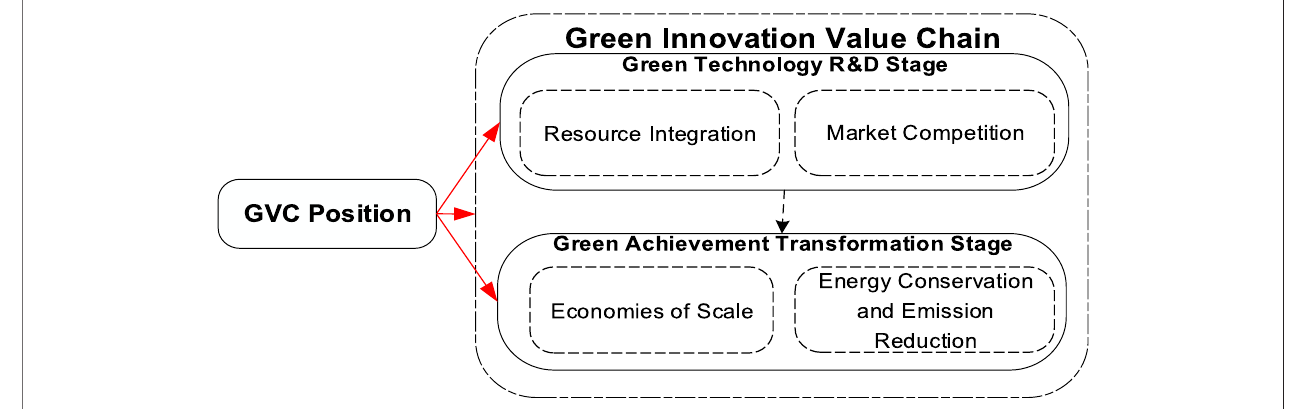
FIGURE 1 | Overall research framework of this